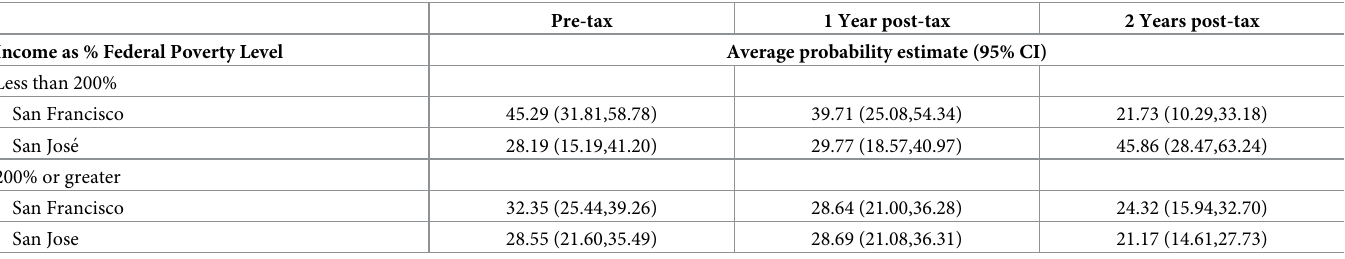
Table 4. Average adjusted predicted probability of high SSB consumption a in San Francisco and San Jose before, one, and two years after San Francisco’s sugar sweetened beverages tax implementation, stratified by federal poverty level (FPL) (n =